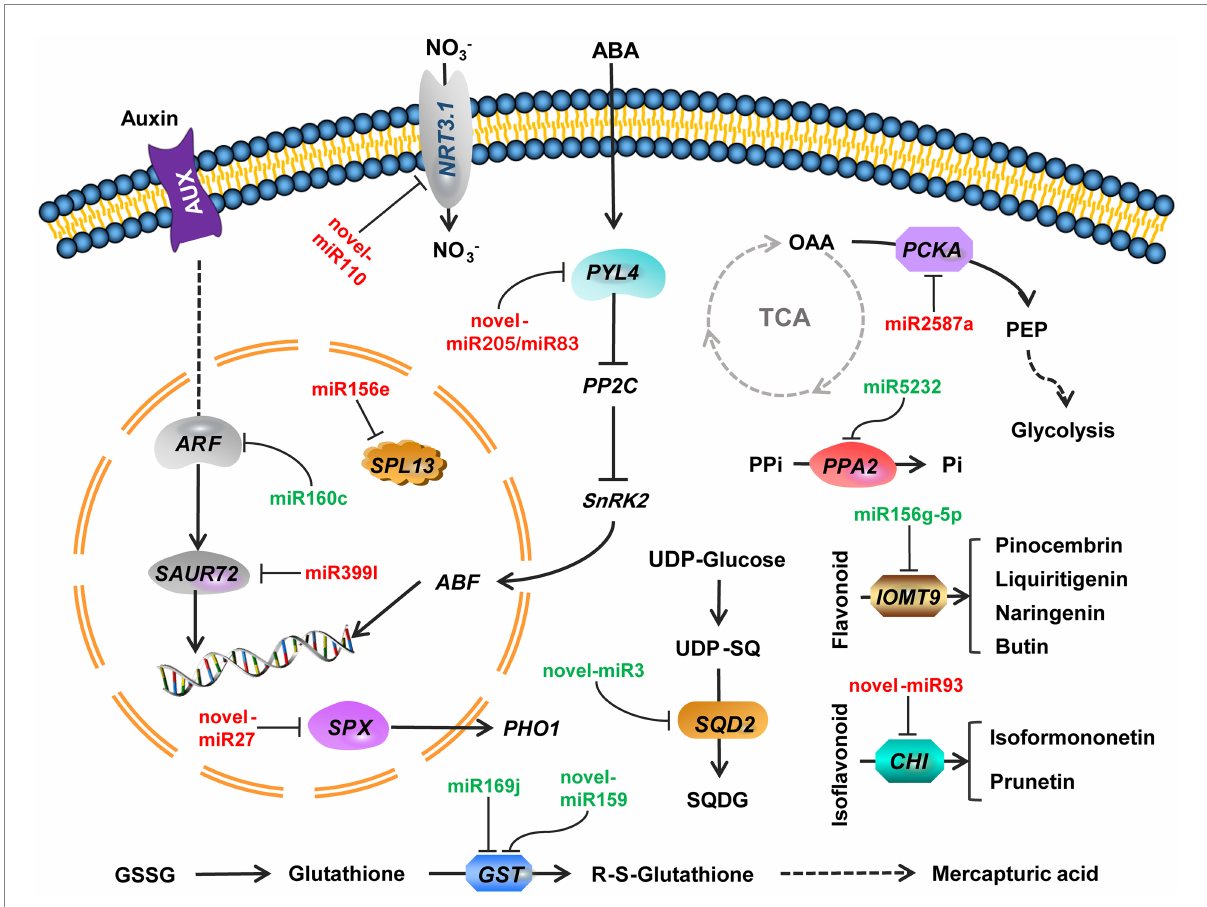
FIGURE 5 Regulatory pathways of combined miRNA-mRNA responses to Pi deficiency stress in alfalfa roots. Green miRNA represents decreased expression. Red miRNA represents increased expression. Arrows indicate positive regulation. NRT3.1 , high-affinity nitrate transporter 3.1 ; ARF , auxin response factor 18 isoform X1 ; SAUR72 , auxin-responsive protein SAUR72 ; PYL4 , abscisic acid receptor PYL4 ; PP2C , Protein phosphatase 2C ; SnPK2 , serine/ threonine-protein kinase SAPK2 ; ABF , abscisic acid-insensitive ; SPX , SPX domain protein ; PHO1 , phosphate transporter ; SPL13 , squamosa promoter-binding-like protein 13A ; PPi , pyrophosphoric acid ; PPA2 , Inorganic pyrophosphatase 2 ; OAA , Oxaloacetate ; PCKA , phosphoenolpyruvate carboxykinase ( ATP ); PEP , Phosphoenolpyruvate ; SQD2 , sulfoquinovosyl transferase SQD2 ; SQDG , sulfoquinovosyl- diacylglycerol ; GSSG , Glutathione disulfide ; GST , glutathione S-transferase ; IOMT9 , isoflavone-7-O-methyltransferase 9 ; CHI , Chalcone— flavonone isomerase